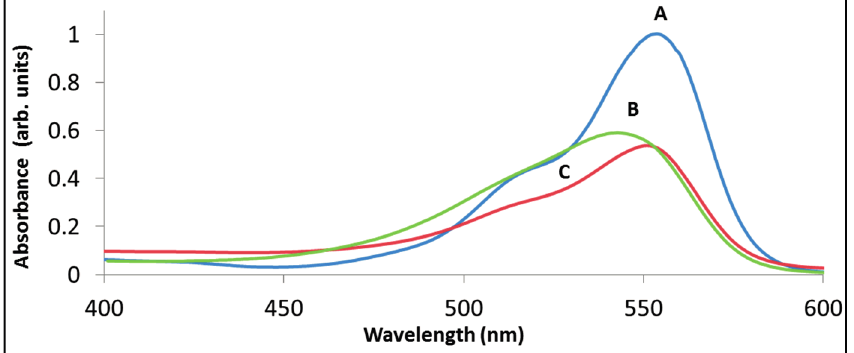
Figure 4. The degradation of rhodamine B with BiOCl (B) and with La 2 BiNbO 7 (C) under visible light. Trace (A) presents the spectrum of RhB prior to degradation, peaked at 554 nm. Traces (B) and (C) present the spectrum at a point where 48% of the initial absorbance at at 554 nm has